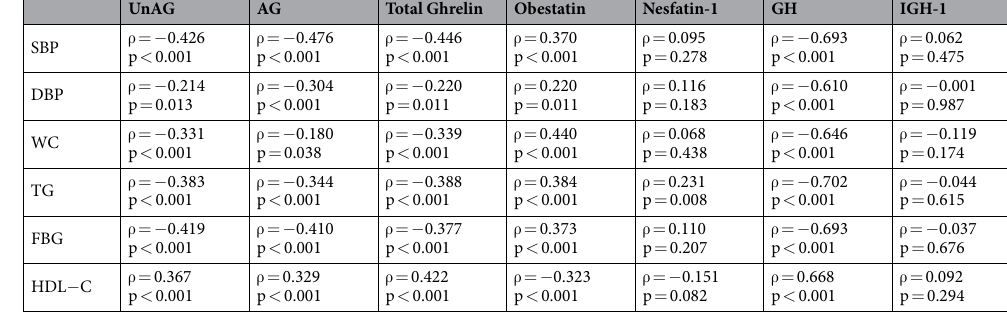
Table 2. Correlation between ghrelin gene products, nesfatin-1, GH, IGF-1 and cardiometabolic risk factors. UnAG, AG, total ghrelin and GH were positively correlated with HDLC only but negatively correlated with the remaining cardiometabolic risk factors (SBP, DBP, WC, TG and FBG). Obestatin correlated negatively with HDLC but correlated positively with all other MetS risk factors. Nesfatin-1 correlated positively with TG alone whereas, IGF-1 showed no correlation with all MetS risk factors. UnAG, unacylated ghrelin; AG, acylated ghrelin; SBP, systolic blood pressure; DBP, diastolic blood pressure; WC, waist circumference; TG, triglycerides; FBG, fasting blood glucose; HDL-C, high-density lipoprotein cholesterol; Spearman’s correlation was employed for the correlation analysis. Significance level was set at p < 0.05.